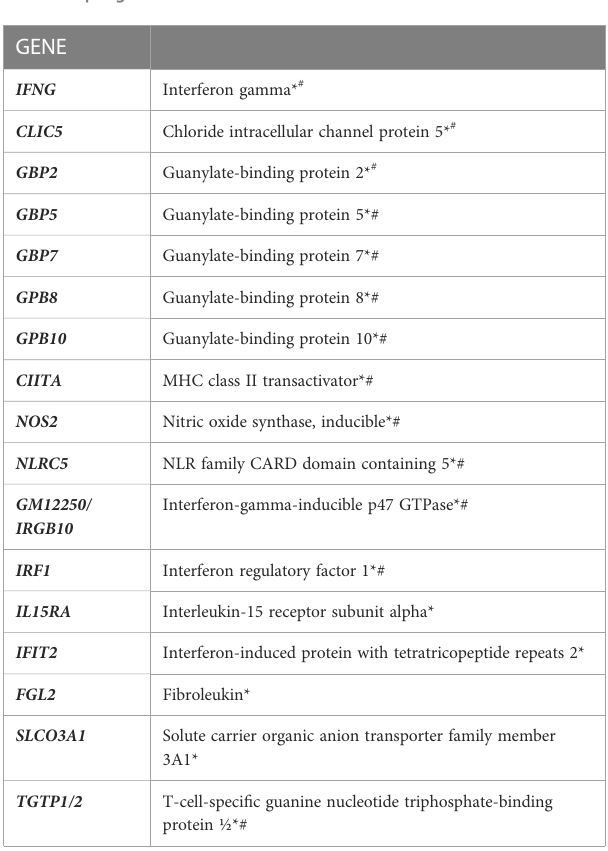
TABLE 1 RNA sequencing revealed signi fi cant increases in 17 genes of interest due to IL-27 stimulation for 24 hours in thioglycolate-induced M1 macrophages.